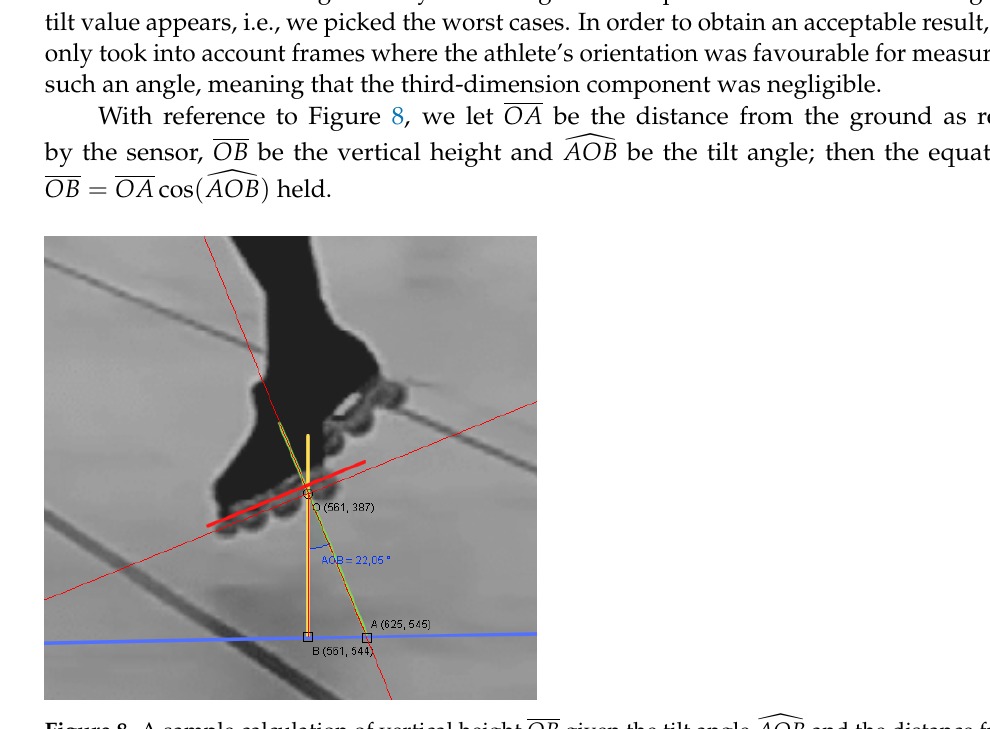
Figure 8. A sample calculation of vertical height OB given the tilt angle the ground OA .